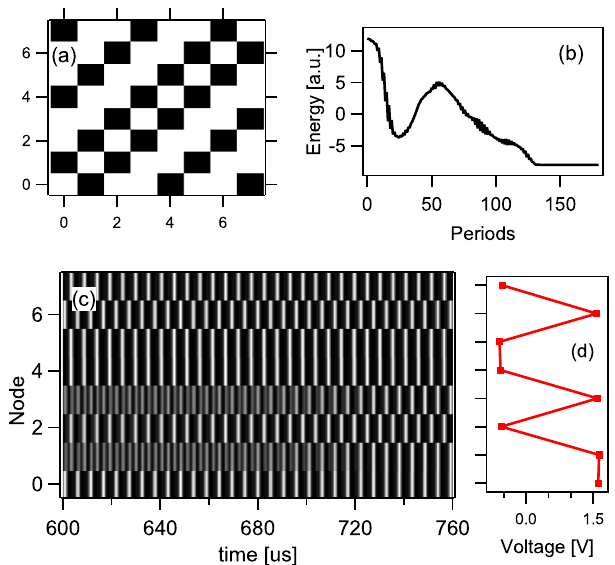
Fig. 4 Experimental evolution to degenerate ground state. a The coupling matrix for N = 8 Möbius-ladder graph. b The time evolution of the system ’ s energy, settling at the ground-state energy of E = − 8 after around 130 subharmonic periods; interestingly the system arrives there non- monotonically. c the circuit response encoding the solution of lowest energy, depicted as the temporal voltage snapshot in ( d